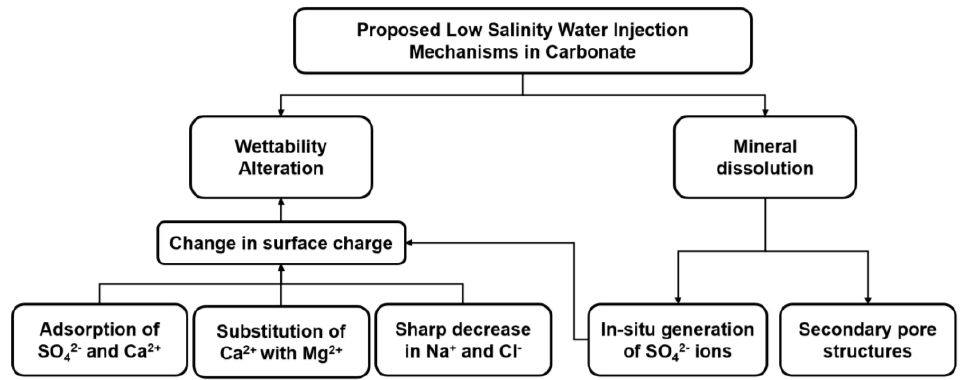
Figure 4. Summary of proposed mechanisms of low salinity water injection in